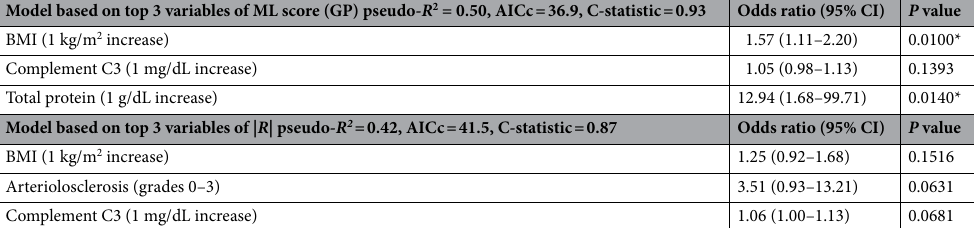
Model based on top 3 variables of ML score (GP) pseudo- R 2 = 0.50, AICc = 36.9, C-statistic =